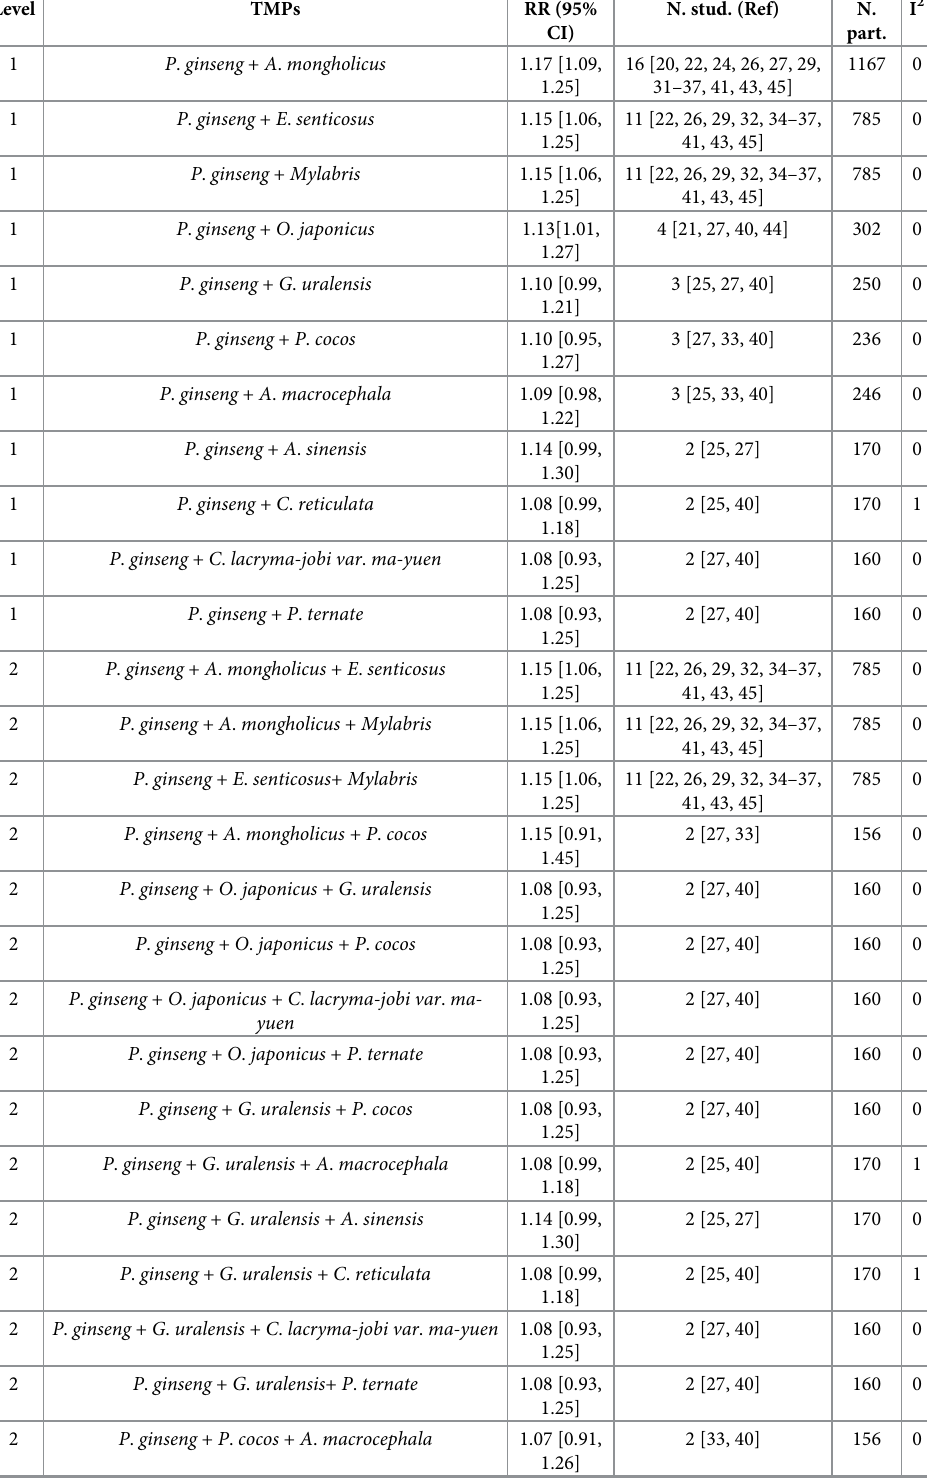
Table 6. Effects of specific G-TMPs on DCR for AGC: Combination of Ginseng and other